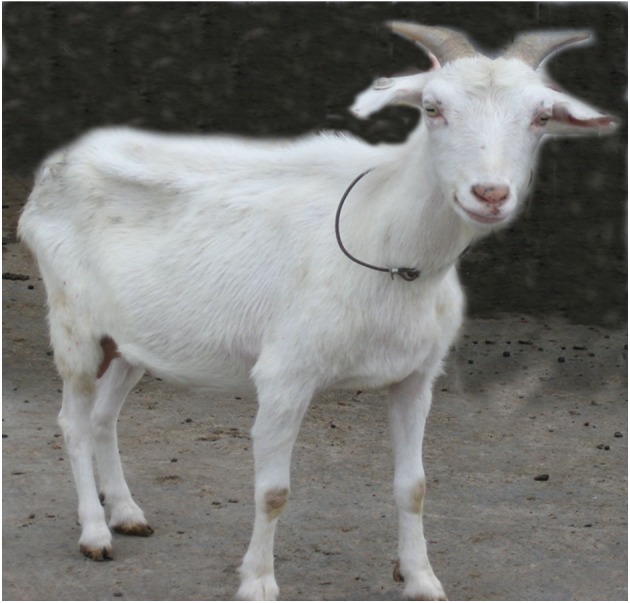
A Haimen goat ram.